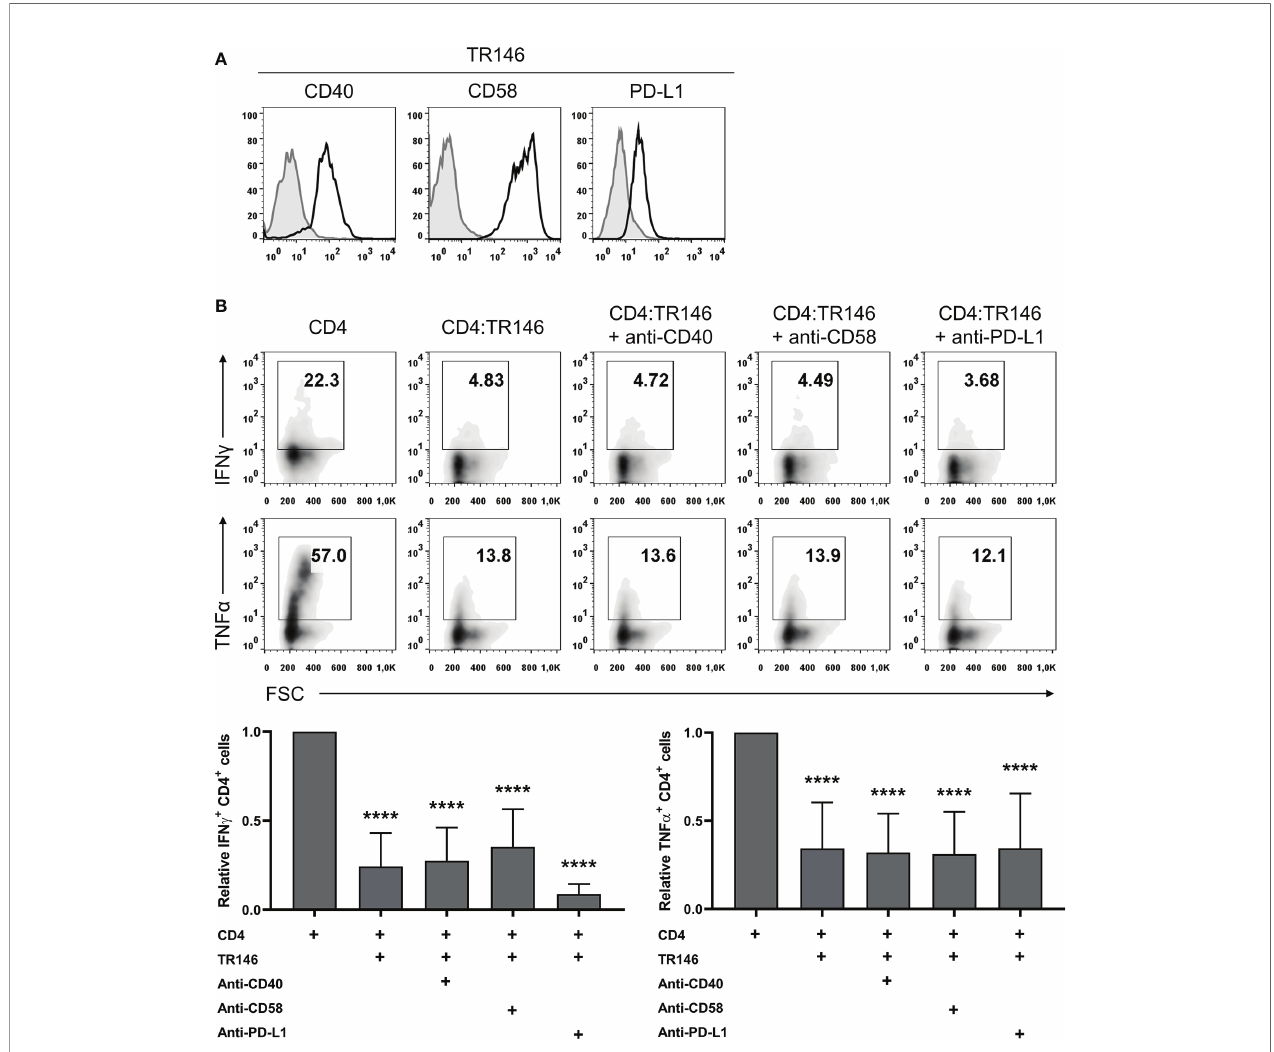
FIGURE 3 | CD40, CD58 or PD-L1 in TR146 cells do not participate in CD4 T cells inhibition. (A) TR146 cells surface expression of CD40, CD58 and PD-L1 (black) compared with isotype control (grey), as detected by fl ow cytometry. (B) TR146 cells were incubated with anti-CD40, anti-CD58 or anti-PD-L1 blocking antibodies for 15 min and cultured with CD3/CD28-activated CD4 T cells for 4 hours. Activated CD4 T cells were cultured alone as a control. Data were collected by fl ow cytometry and shown as the percentage of IFN g and TNF a -producing CD4 T cells from a representative experiment (density plots) and relative to CD4 T cells alone when considering all experiments (bar graphs). FACS gatings were adjusted by the use of mouse anti-IgG-PE and anti-IgG-APC antibodies. Bar graphs display mean values with SEM error bars. Statistically signi fi cant differences were obtained applying ANOVA tests. Signi fi cant differences (p < 0.001) are noted as “ **** ” . Data were obtained from a total of four independent experiments using samples from different